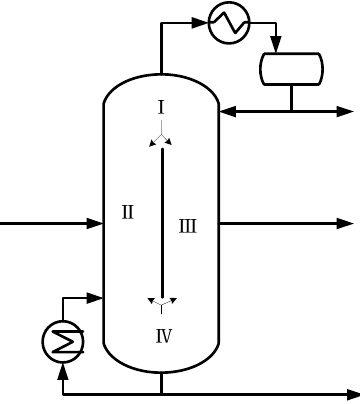
Figure 4. Four sections in dividing wall column (DWC).